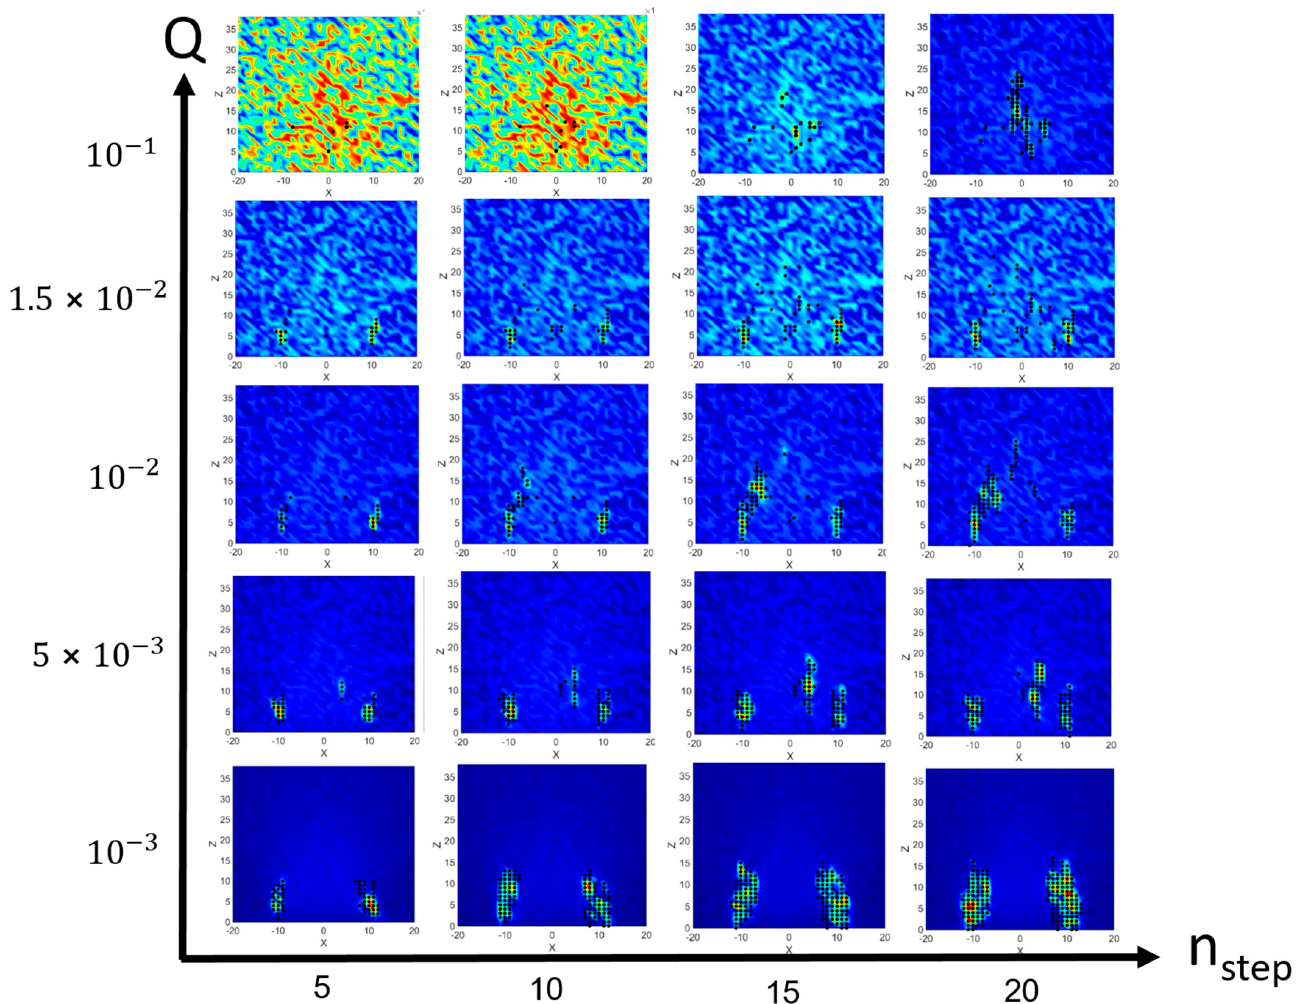
Figure 7. Effect of Q characterizing the disorder in the yield strain from Equation (1), on the localization of plastic rearrangements, for different number of steps, with Q* = 0.01 and S = 0.100 and initial defects with ε xy = 10.1 ε d max . With our choice of loading F z , the maximum deviatoric strain ε d max due to Hertz contact in the absence of disorder is equal to 0.65 × 10 − 2 here.